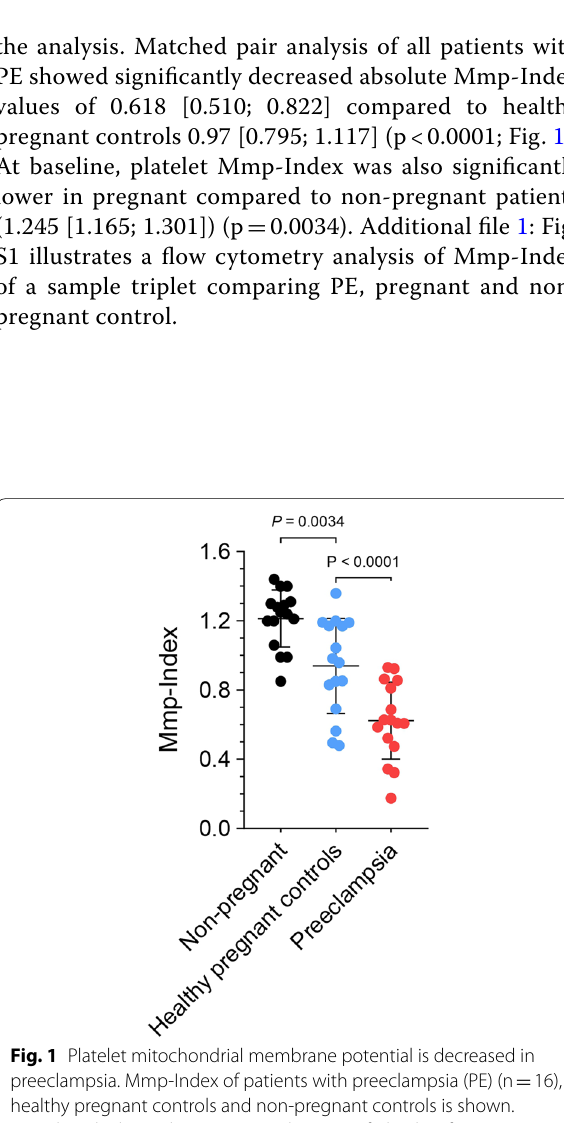
Values show median and [interquartile range]. Pregnant control represents the 16 controls for the PE antepartum group